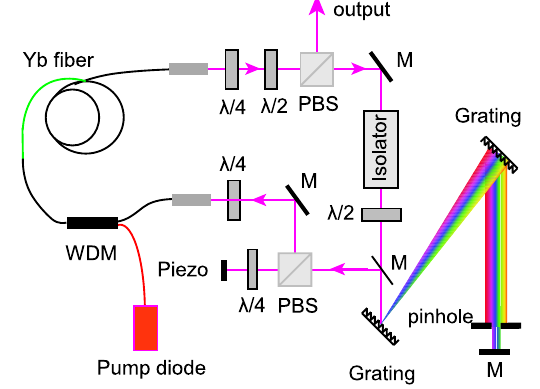
FIG. 3. Schematic of the 50 MHz oscillator cavity: λ = 2 , half- wave plate; λ = 4 , quarter-wave plate; PBS, polarization beam splitter; M, mirror; grating, 1200 lines per mm; WDM, wave- length division multiplexer; Yb fiber, 55-cm ytterbium-doped gain